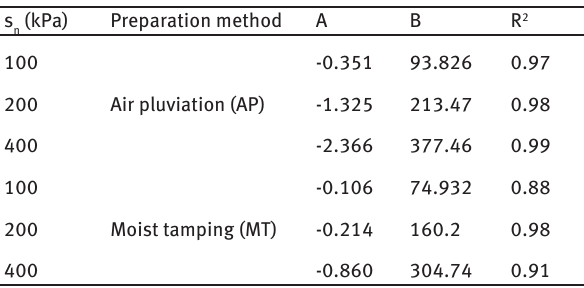
Table 7: Coefficients A, B and R 2 for equation (3) (RD = 80%). s n